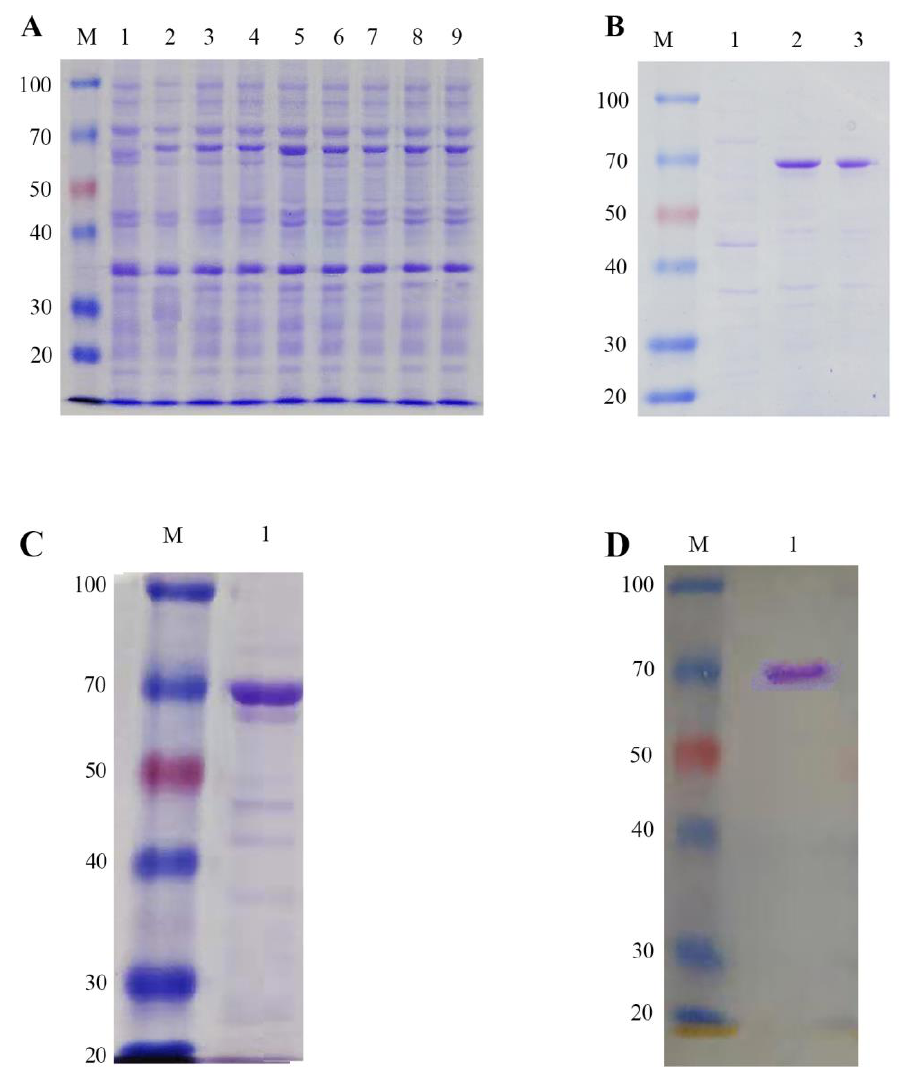
Figure 8. The recombinant protein LoTRE1 was expressed and purified. ( A ) Expression of recombi- nant LoTRE1 protein induced with IPTG under various conditions. Lane M: molecular weight marker. Lane 1: Uninduced cells of E. coli Rosetta (DE3). Lanes 2 – 4: The protein production in the E. coli Rosetta (DE3) cells induced with 0.1, 0.4, 0.8, and 1.0 mmol/L IPTG at 28 °C. Lanes 5 – 9: Protein production in the E. coli Rosetta (DE3) cells induced with 0.1, 0.4, 0.8, and 1.0 mmol/L IPTG at 37 °C. ( B ) Determination of the target protein ’ s expression form. Lane M: molecular weight marker. Lane 1: Uninduced cells of E. coli Rosetta (DE3). Lane 2: The target protein in the supernatant after sonication and centrifugation. Lane 3: The target protein in the sediments after sonication and centrifugation. ( C ) Purification of the LoTRE1 recombinant protein. Lane M: Molecular weight marker. Lane 1: Purified target protein. ( D ) Western blot. Lane M: Molecular weight marker. Lane 1: Purified target